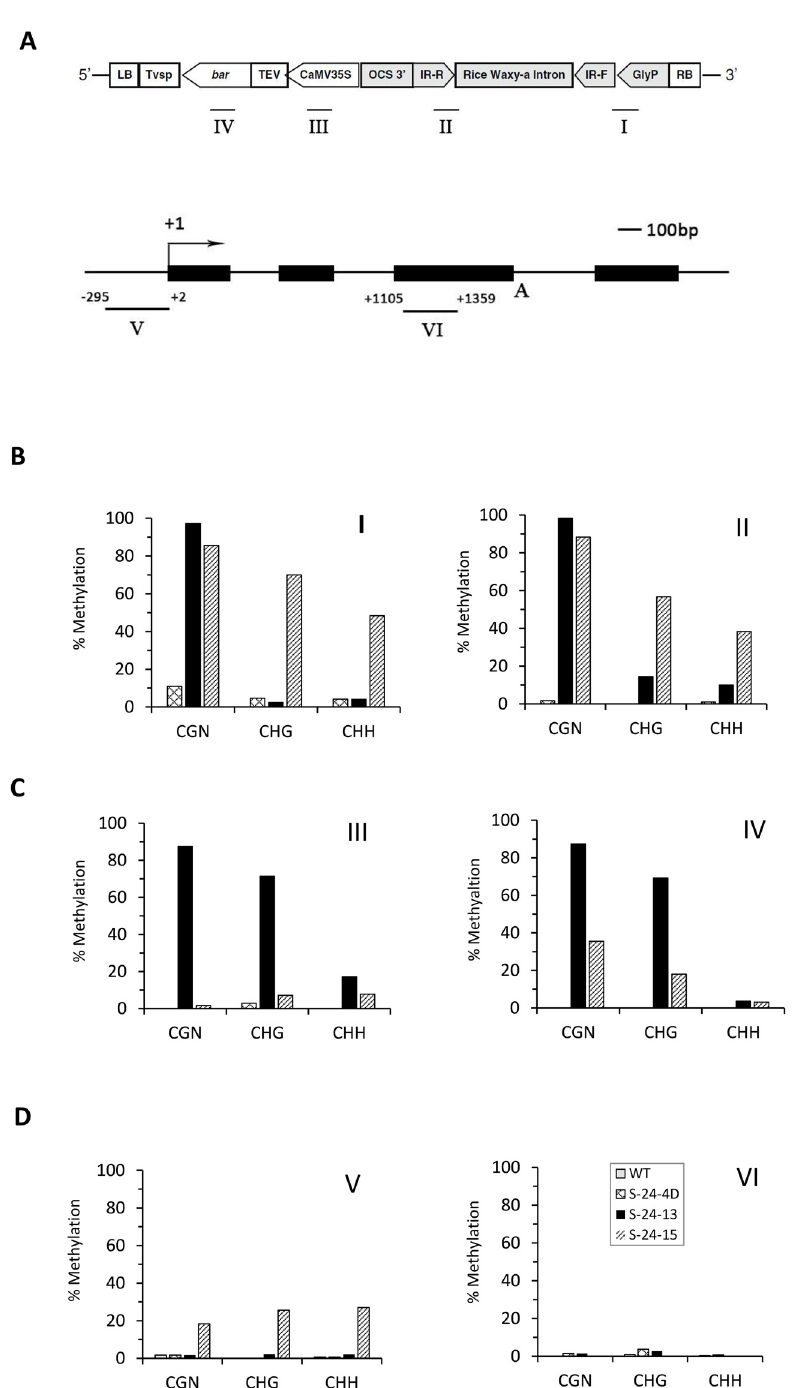
Fig 3. DNA methylation analysis of T 5 homozygous RNAi lines. (A) Schematic presentation of the T-DNA region of the plant transformation vector, pMUFAD. The expression cassette for the RNAi of GmFAD3 is highlighted in grey. Note: LB and RB, T-DNA left and right borders, respectively; Tvsp, soybean vegetative storage protein gene terminator; bar , bialaphos resistance gene; TEV, tobacco etch virus translational enhancer; CaMV35S, cauliflower mosaic virus 35S promoter; OCS 3 ’ , octopine synthase gene terminator; IR-R and IR-F, the 318-bp inverted repeats of GmFAD3 target sequence in reverse and forward directions, respectively; Rice Waxy-a Intron, rice Waxy-a gene intron; GlyP, soybean glycinin gene promoter. Lines beneath the schematic represent region I, II, III and IV examined by bisulfite sequencing. (B) Schematic of